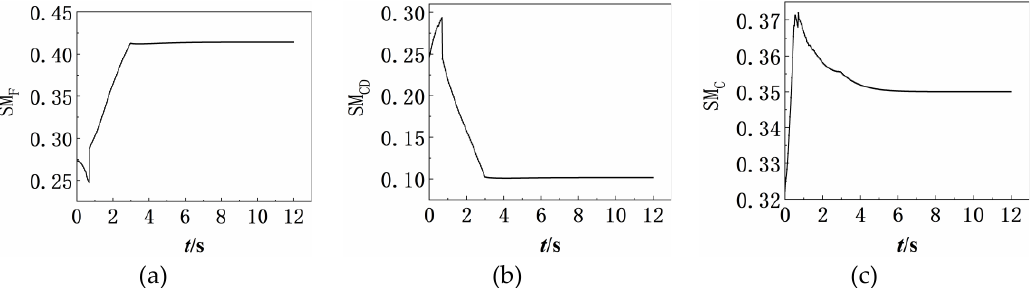
Figure 22. Change curves of the surge margin of working-mode switching from single bypass to double bypass at H = 11 km, Ma = 1.2. ( a ) Surge margin of fan; ( b ) surge margin of CDFS; ( c ) surge margin of HPC.